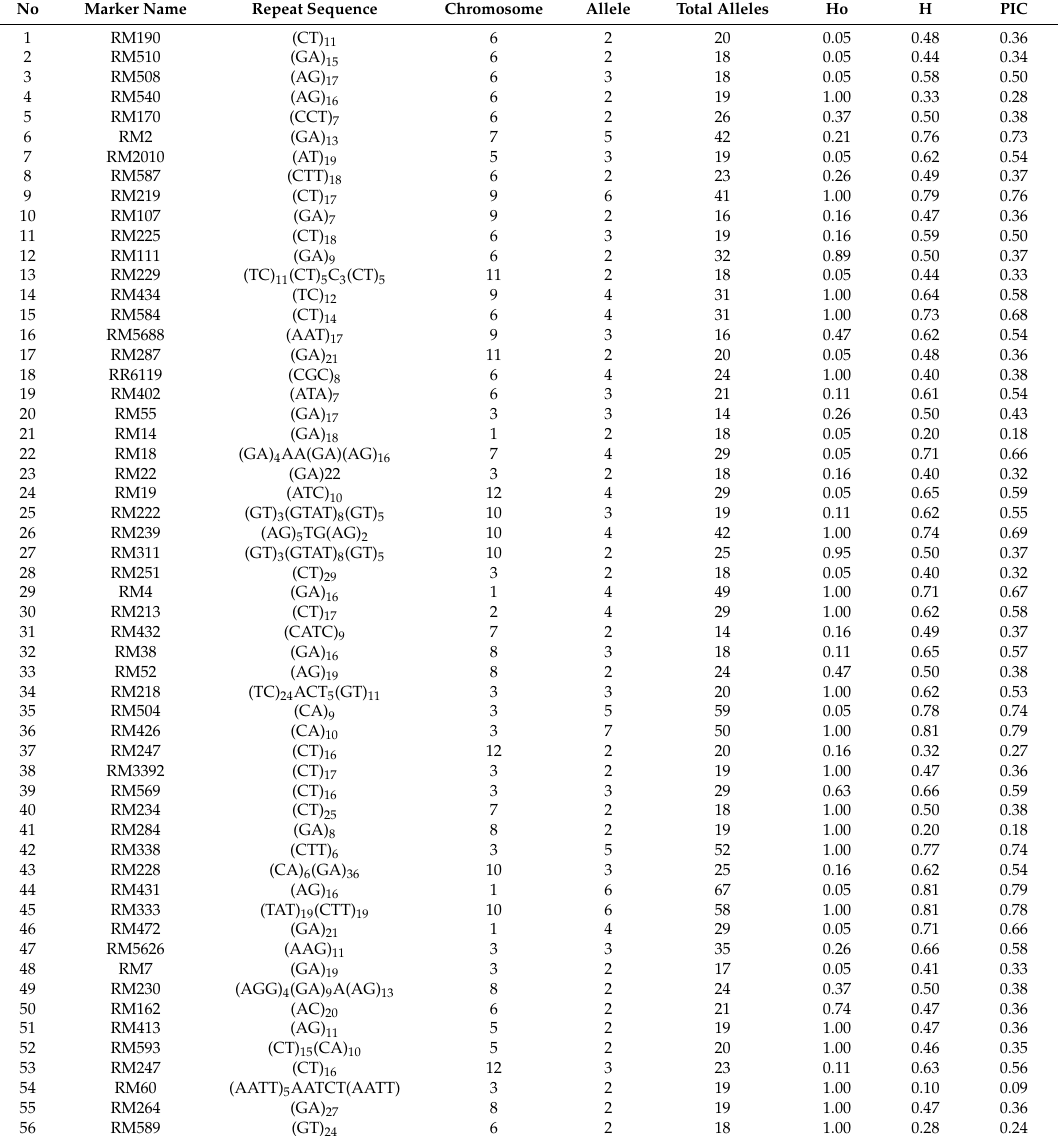
Table 4. Profiles of Simple Sequence Repeat (SSR)